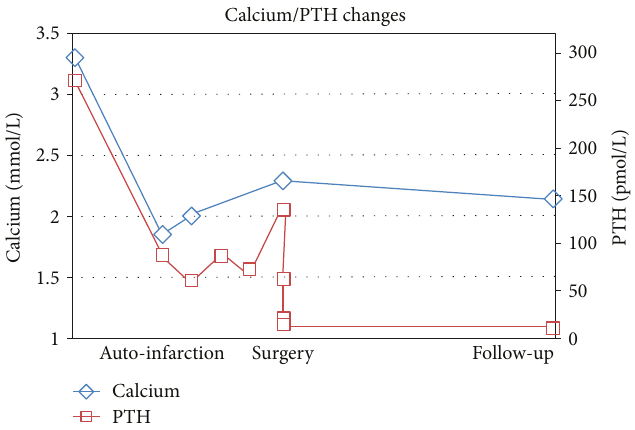
Figure 3: Course of calcium and PTH levels related to the di ff erent events.